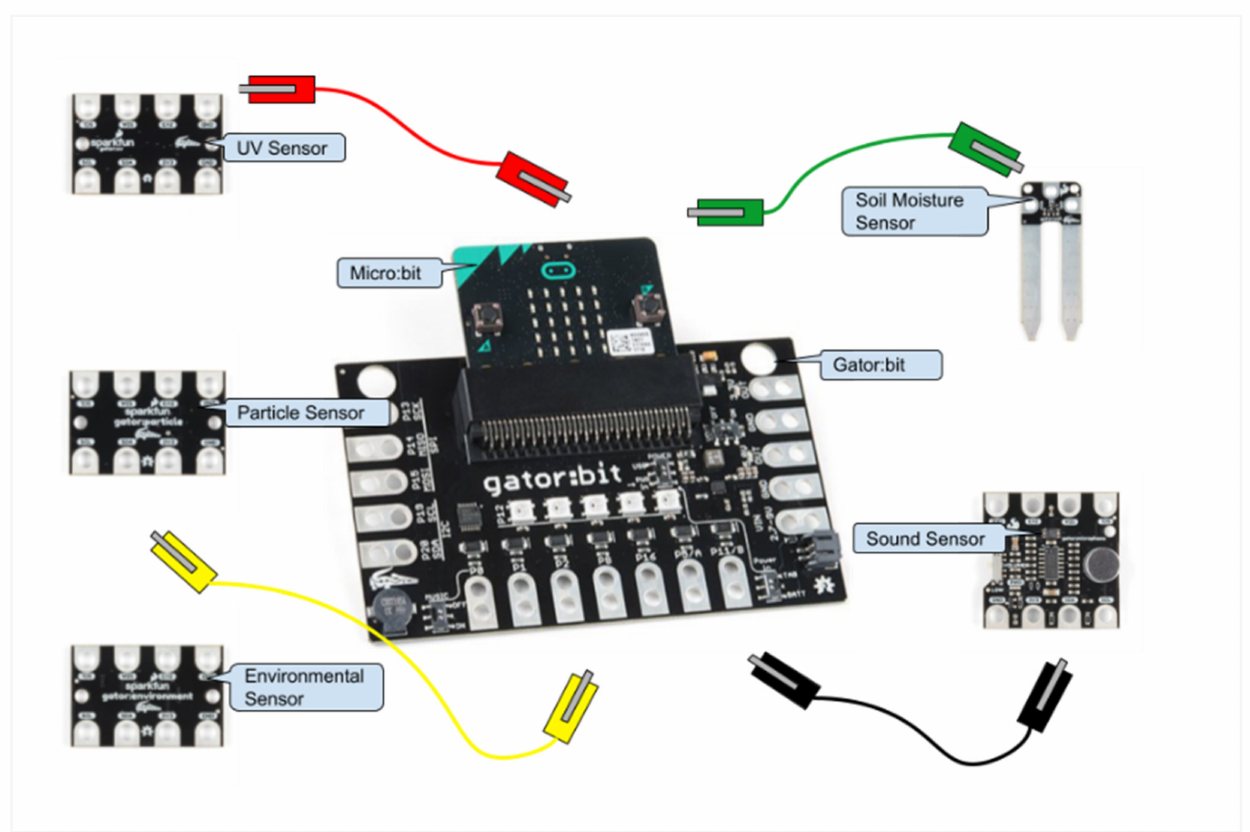
Figure 1. The components of the sensor-based physical computing system, the Data Sensor Hub